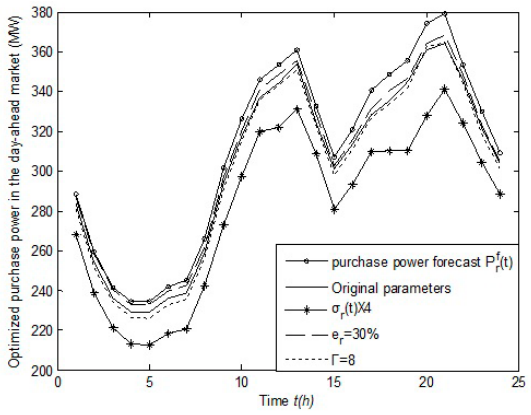
Figure 10. P o ( t ) in the day-ahead market when σ r , Γ , and e r change, respectively. Figure 10. P o r r ( t ) in the day-ahead market when σ r ,